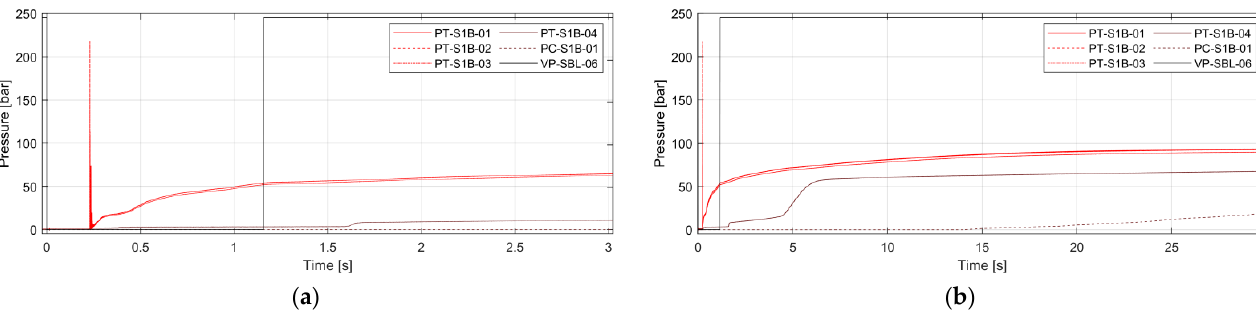
( a ) ( b ) Figure 11. Strain time trends on external surface of S1B reaction vessel. ( a ) zoom on [0–3] s, ( b ) zoom on [0–30] s. Figure 12. T emperature time trends in S1B at different rings (from Ring 1 to Ring 6, see Figure 3b).